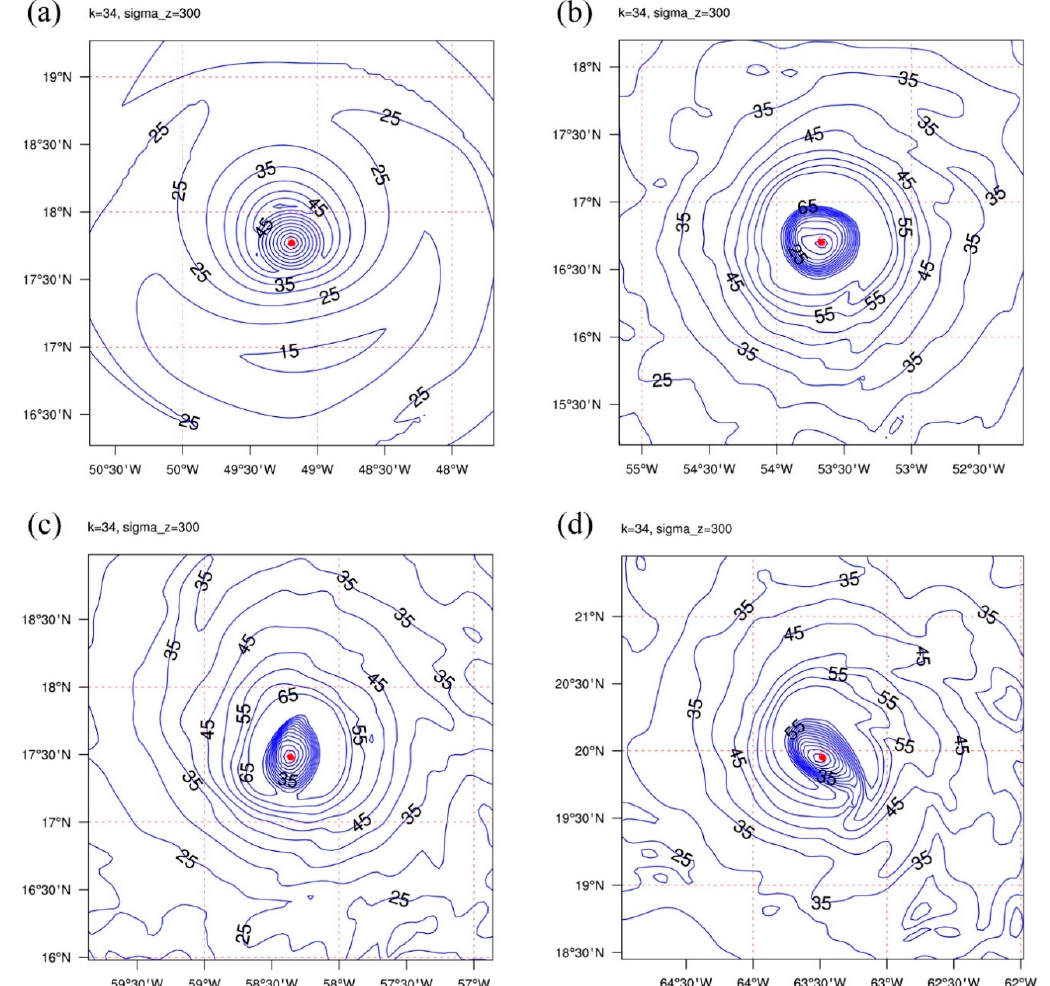
Figure 15. As in Figure 14, except from ( a ) the cold-start COAMPS-TC initial conditions (tau = 0 h) at 1800 UTC 3 September as indicated in Figure 8b, the COAMPS-TC forecasts at ( b ) tau + 24 h, ( c ) tau + 48 h, and ( d ) tau + 72 h.